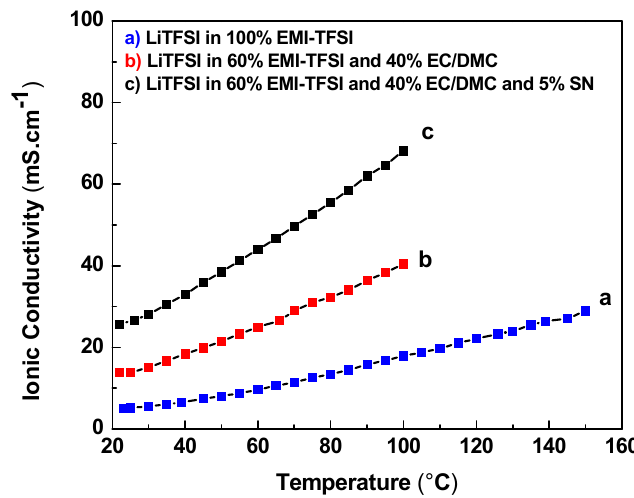
Figure 5. Ionic conductivity vs temperature for the ionic liquid electrolyte (ILE), mixed organic/ionic liquid electrolyte (MOILE), and MOILE with 5 wt.% SN.